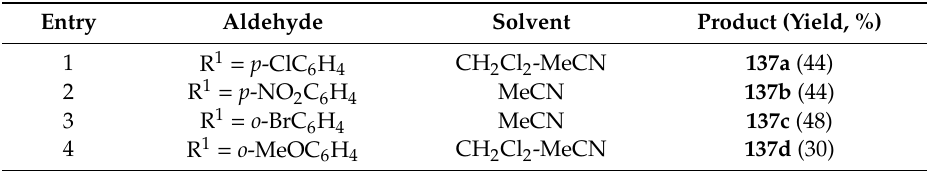
Table 11. Aziridines 137a – d obtained in the reaction of alkynylselenonium salt 134a with aromatic aldehydes and